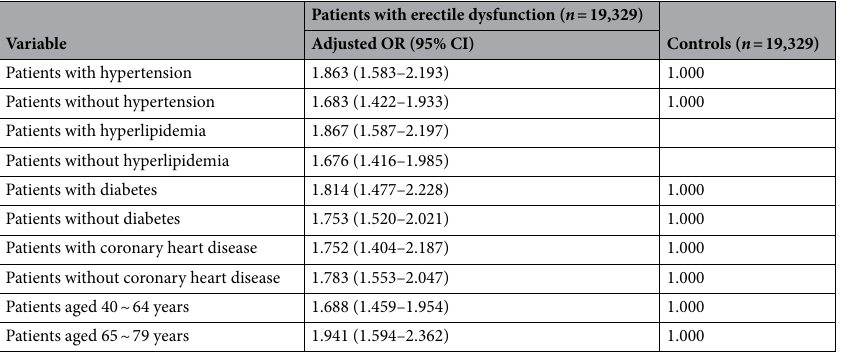
Table 4. Adjusted odds ratio of prior tinnitus among cases vs. controls stratified by the presence of hypertension, hyperlipidemia, diabetes, coronary heart disease and age group. OR odds ratio.